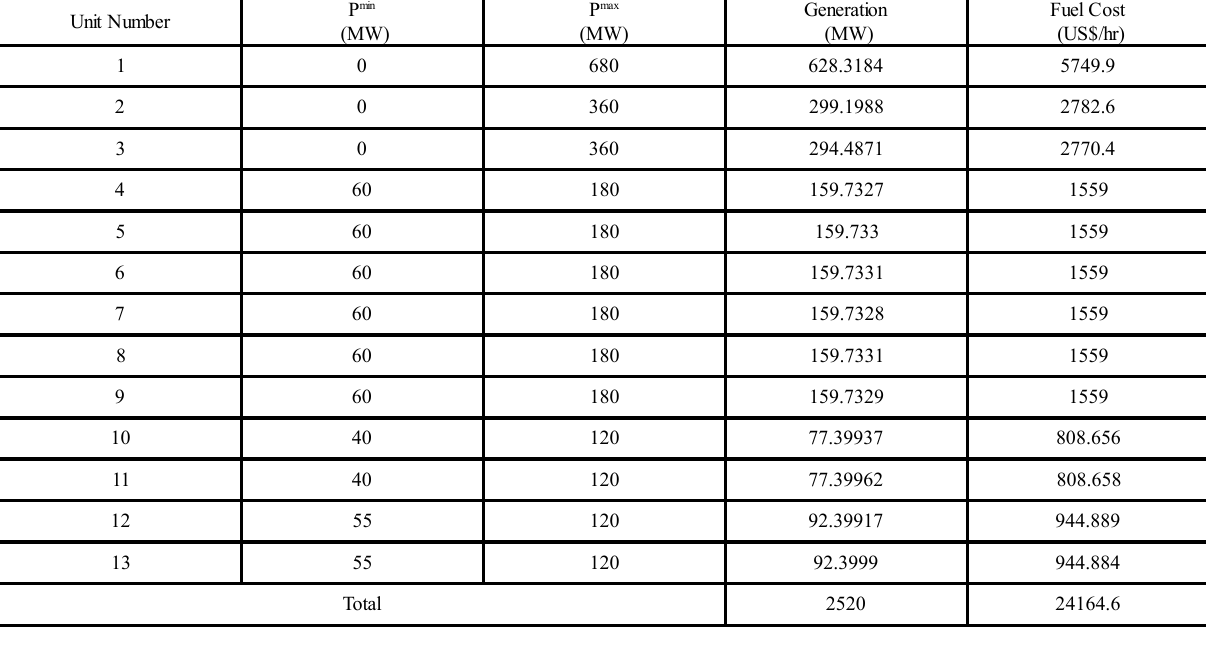
TABLE 2. POWER OUTPUT OF INDIVIDUAL UNIT AND CORRESPONDING COST FOR TEST